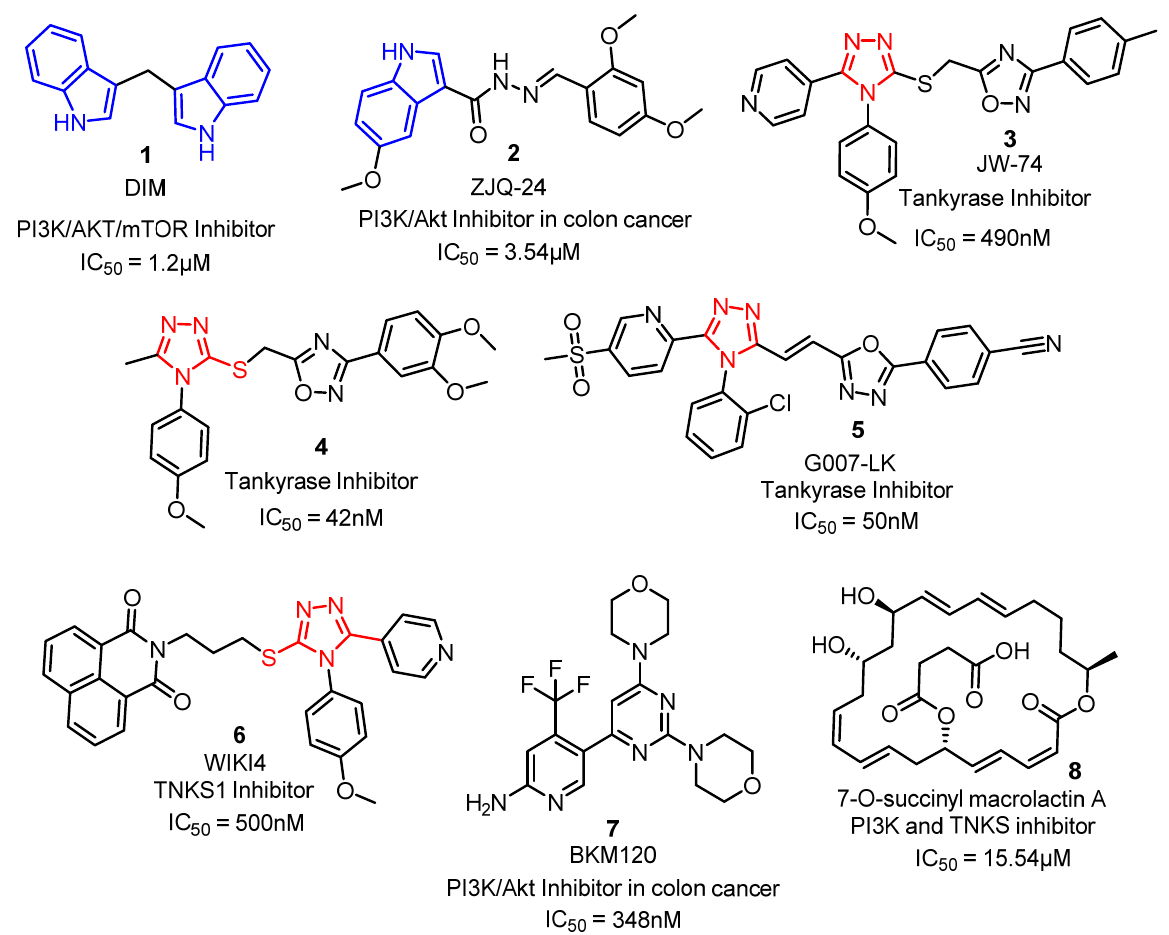
Figure 1. Some of the PI3K and tankyrase inhibitors approved by the FDA and proven in clinical trials.